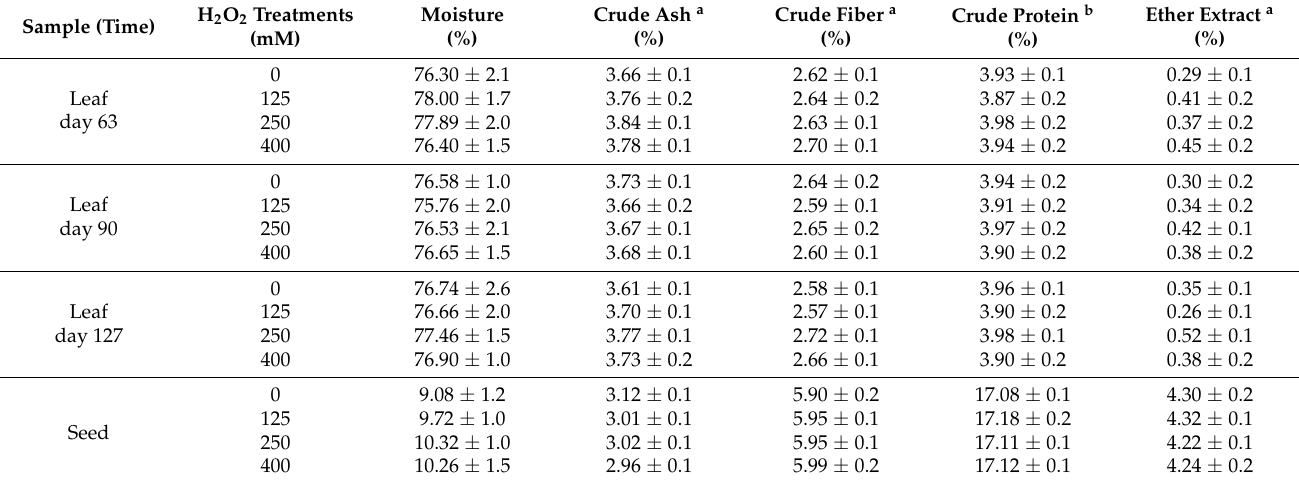
Table 1. Results of the proximate chemical analysis in amaranth leaf and seed ( Amaranthus hypochon- driacus